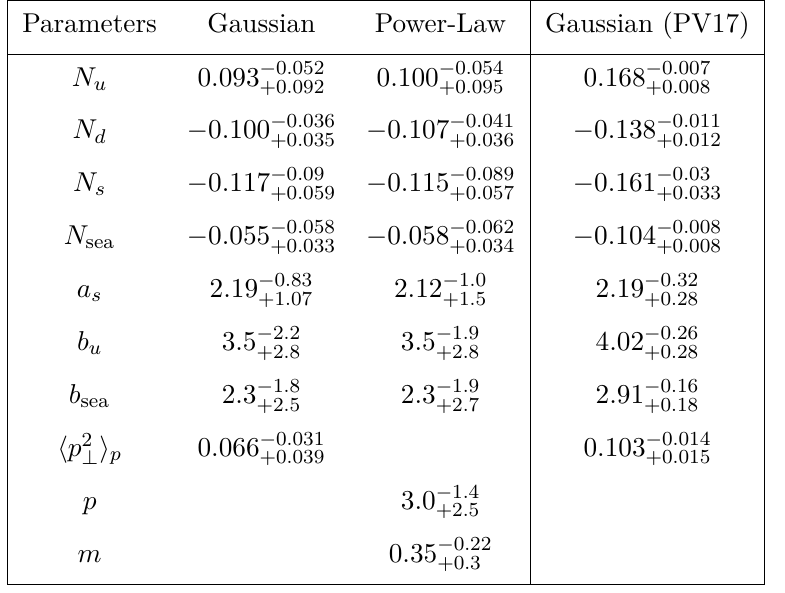
Table 2 . Best parameter values for the first moment of the polarizing FF and for the two nonperturbative functions employed to fit the double-hadron data set.